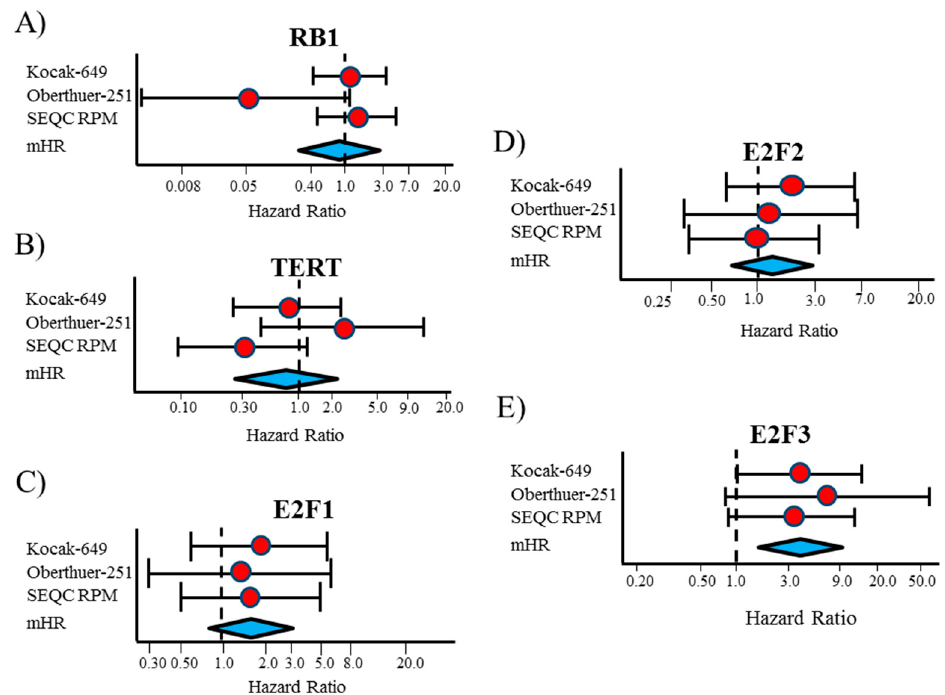
Figure 1. Forest plot of hazard ratios for the association between Event Free Survival of patients with Stage 4S neuroblastoma and the considered gene expressions, categorized on the basis of the median expression value. ( A ) RB1 ; ( B ) TERT ; ( C ) E2F1 ; ( D ) E2F2 ; ( E ) E2F3 . mHR = meta-analytic estimate of HR. Table 1. Hazard ratios for the association between event free survival of patients with Stage 4S neuroblastoma and the considered gene expressions, categorized on the basis of the median expression value.